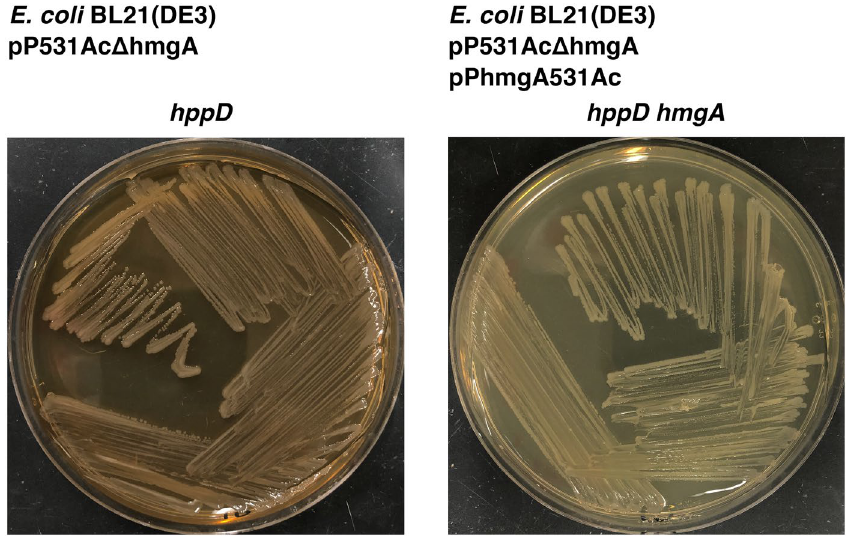
Figure 4. h mgA gene complementation. E . coli BL21(DE3) (pP531Ac Δ hmgA) and E . coli BL21(DE3)